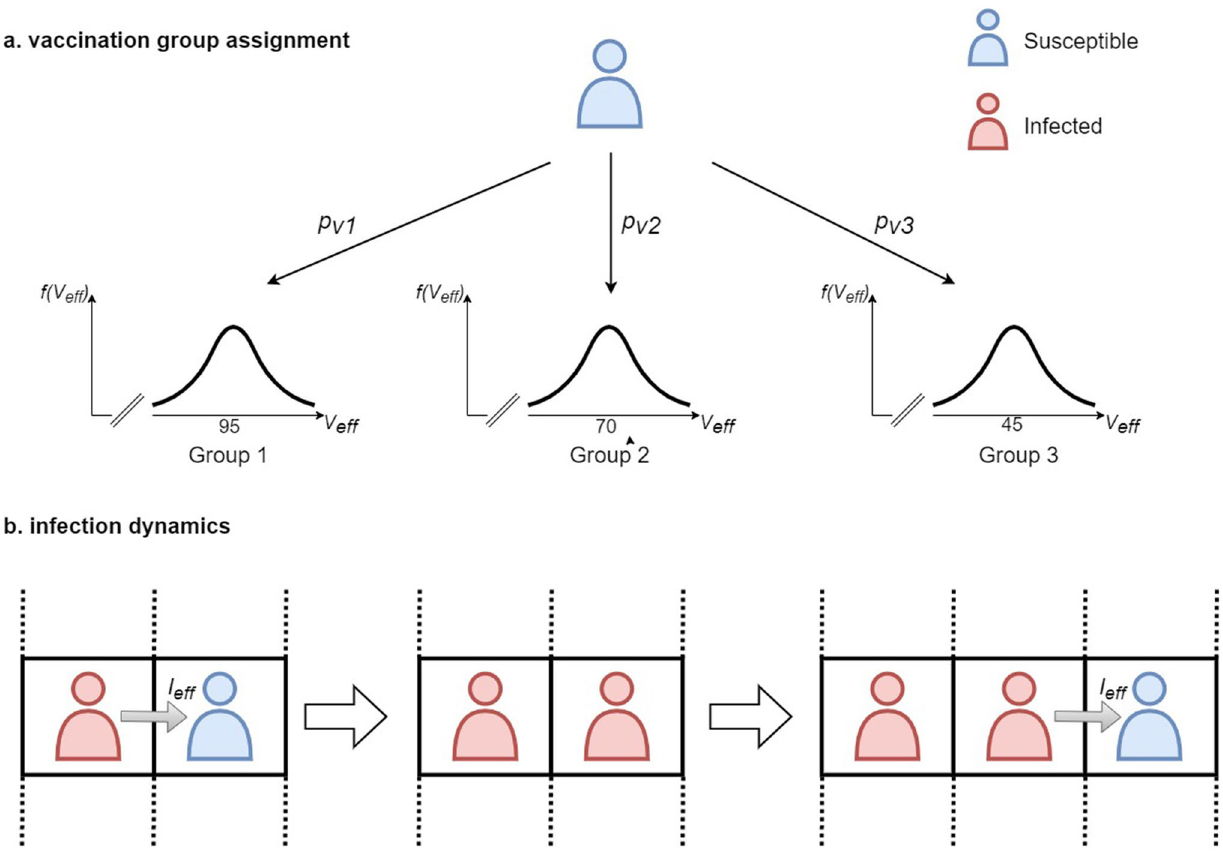
Figure 2. ( a ) shows the assignment of an agent to a vaccination group characterized by the distribution of the vaccine efficacy. Each agent has a predefined probability, p vi , of belonging to a vaccine group i . The vaccine efficacy, V eff , is then sampled from the Gaussian distribution corresponding to that group. ( b ) shows the spread of infection in the population. Infection spreads from direct contact of an infected agent (shown in red) with a susceptible agent (shown in blue) with a probability I eff . Once an agent is infected, they immediately become